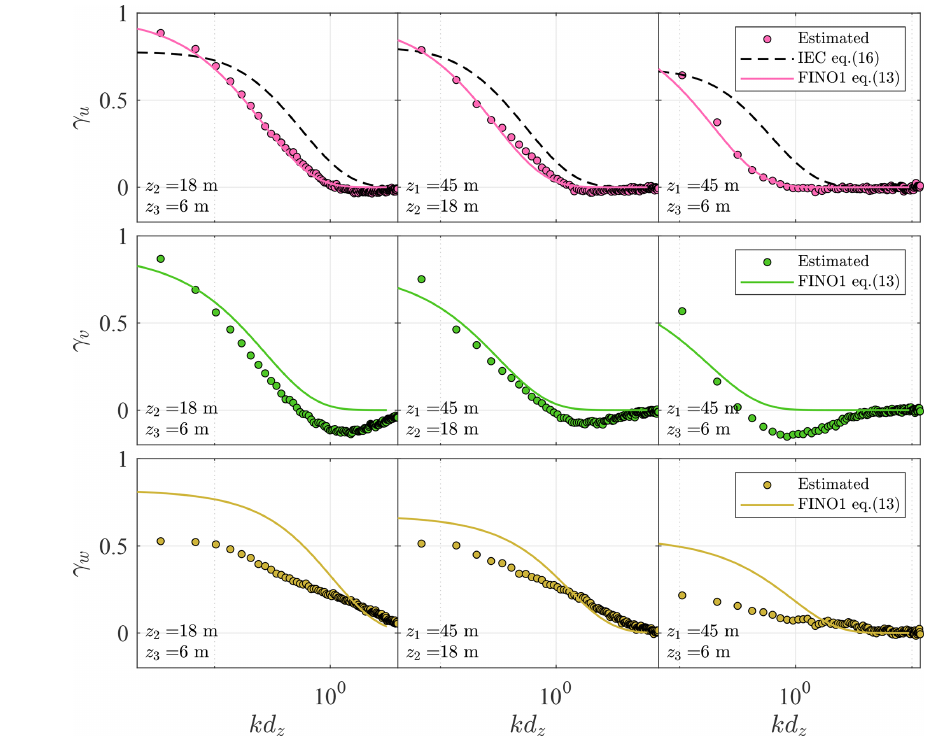
Figure 11. Co-coherences of the along-wind (top panels), lateral (middle panels), and vertical velocity components (lower panels) for | ζ | ≤ 0 . 1 at three different vertical separation distances. The dots represent the measurement, and the lines mark the predictions using the IEC exponential coherence model (dashed line) and the modified Bowen model (solid line) with the fitted coefficients from FINO1 (Cheynet, 2019).